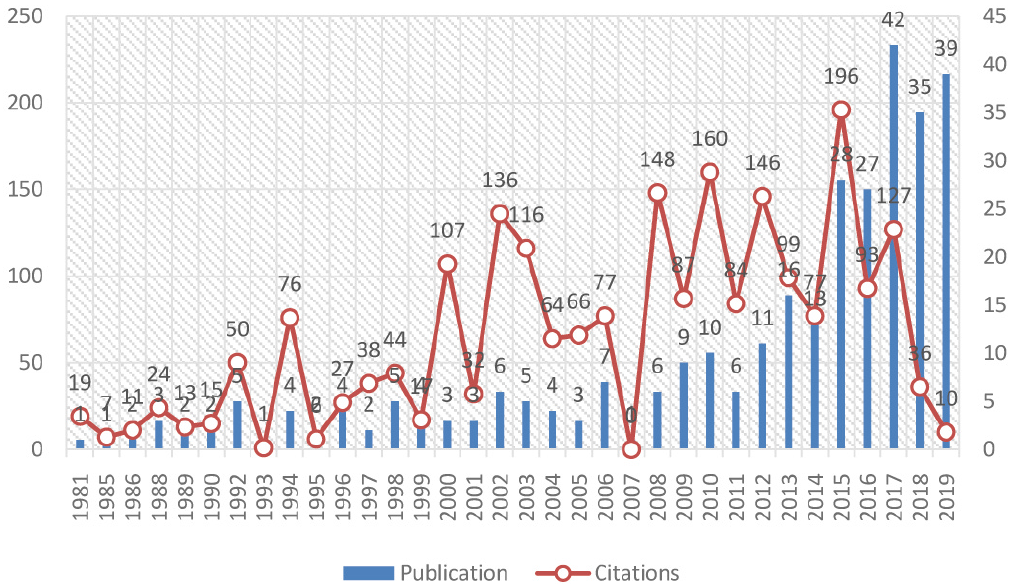
Figure 3. Annual road traffic injuries research productivity in terms of publications and citations in the Gulf Cooperation Council region (1981–2019). (generated using Microsoft Excel).